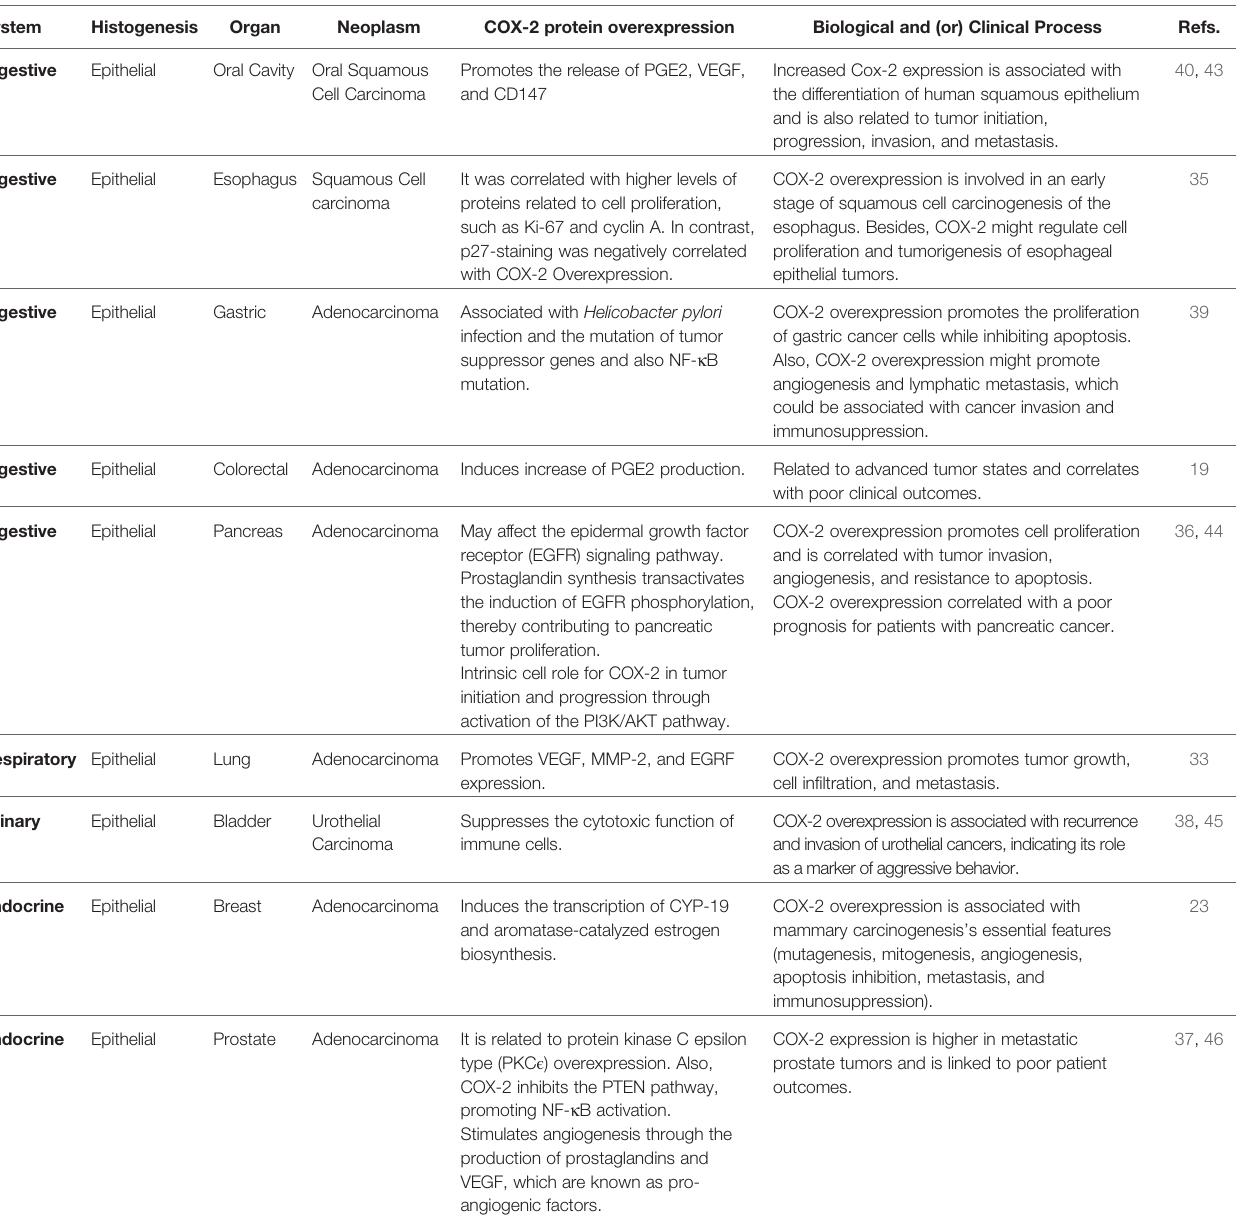
TABLE 1 | COX ‐ 2 protein overexpression related to tumorigenesis and pro-tumoral activity of epithelial cancers (Refs, references). System Histogenesis Organ